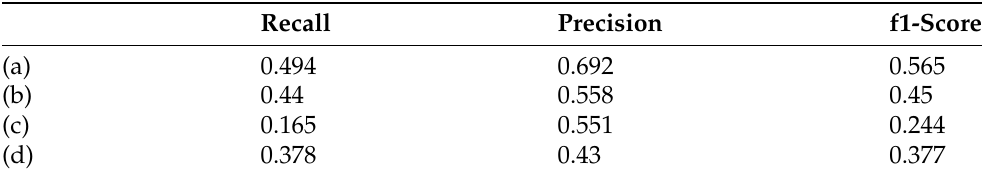
Figure 9. F1-score of segmentation result over ten videos for segmentation with windowing ( a ), auto- matic segmentation ( b ), segmentation by Dukler et al. ( c ) and segmentation by Corinzia et al. ( d ). Table 4. Average recall, precision and f1-score using segmentation with windowing (a), automatic segmentation (b), segmentation by Dukler et al. (c) and segmentation by Corinzia et al.